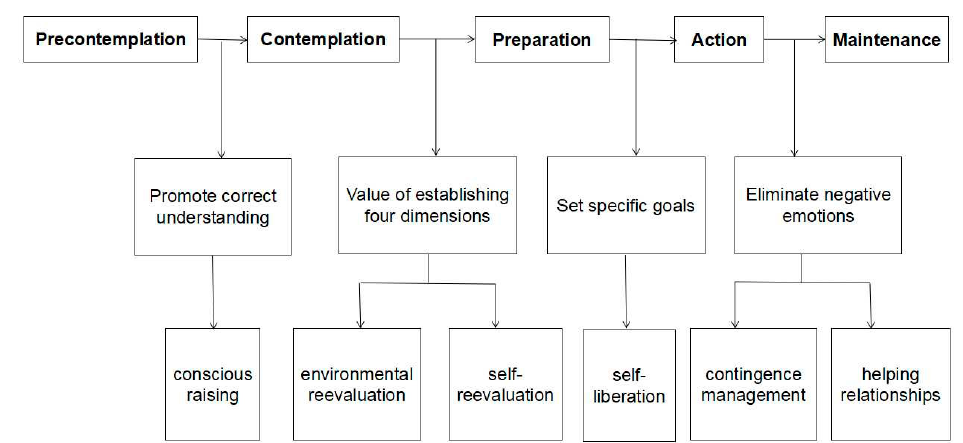
Figure 1. Flowchart of design of group counseling intervention program. Table 1. Growth psychoeducation intervention (GPI) session topics and content overview.